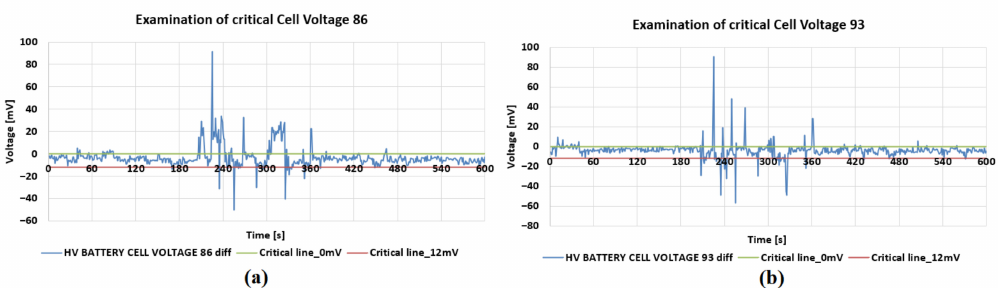
Figure 7. Analysis of test results per critical cell: ( a ) examination of cell 02 with critical support lines; ( b ) examination of cell 54 with critical support lines.